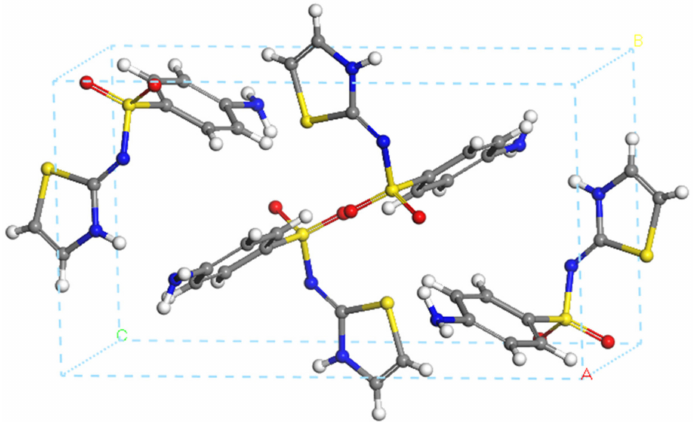
Figure 7. Crystal structure of sulfathiazole. Hydrogen, oxygen, nitrogen, sulfur, and carbon atoms are represented by the colors white, red, blue, yellow, and gray, respectively. A, B, C is X, Y, Z axis, respectively.